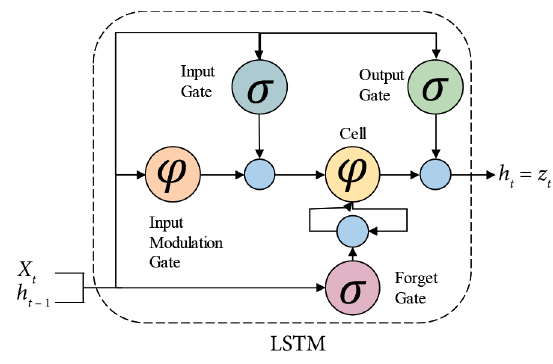
Figure 2. LSTM structure (Kang,